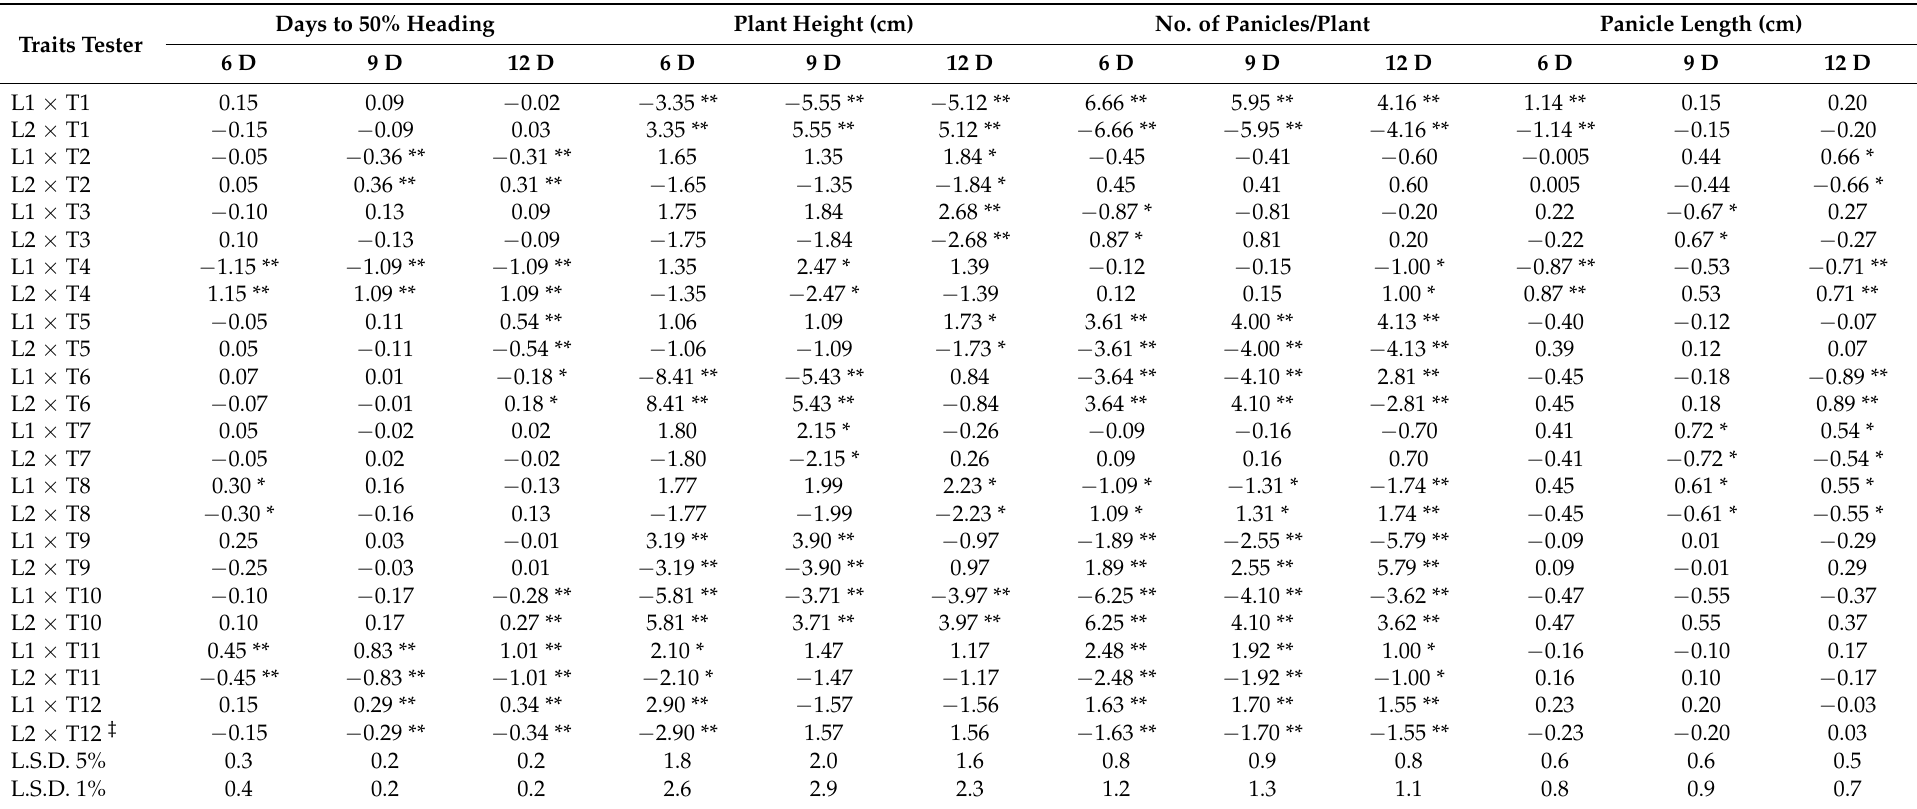
Table 8. Specific combining ability effects of the crosses for days to 50% heading, plant height, no. of panicles/plant and panicle length traits. Traits